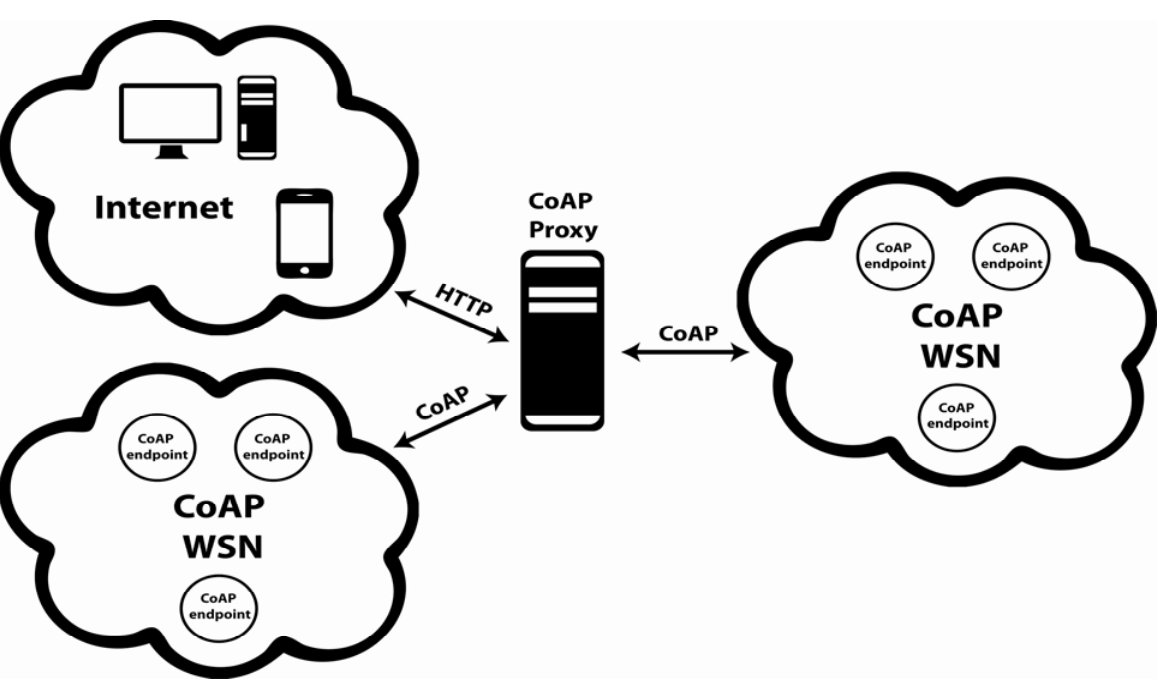
Figure 3. Architecture of a CoAP-based Wireless Sensor Network (WSN). The proxy enables integration between the WSN and external networks that use HTTP